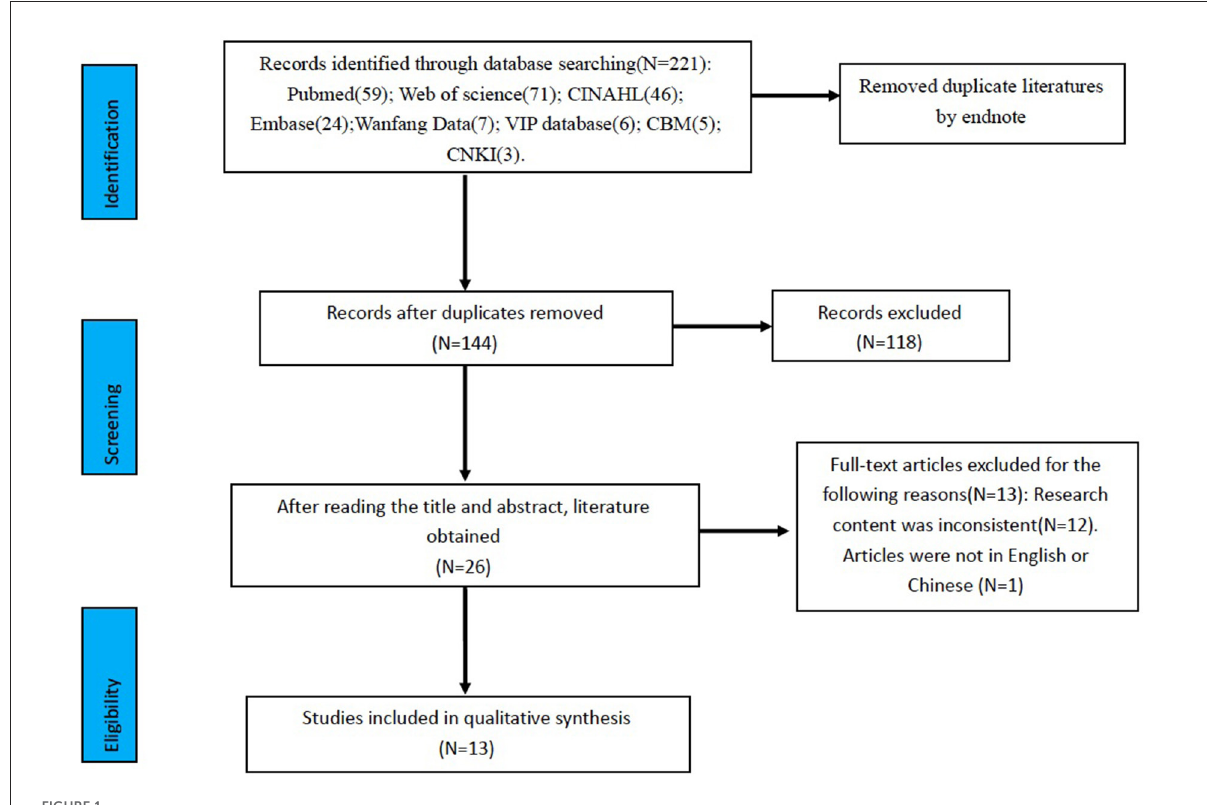
FIGURE1 Flow diagram of literature selection.